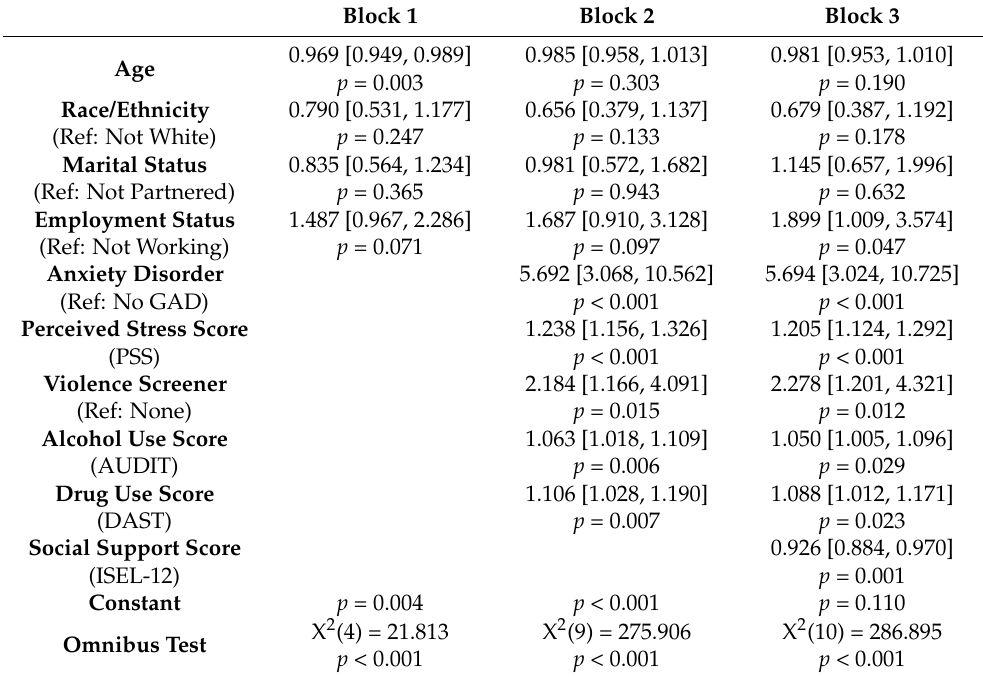
Table 4. Hierarchical Binary Logistic Regression—Predicting Major Depressive Disorder